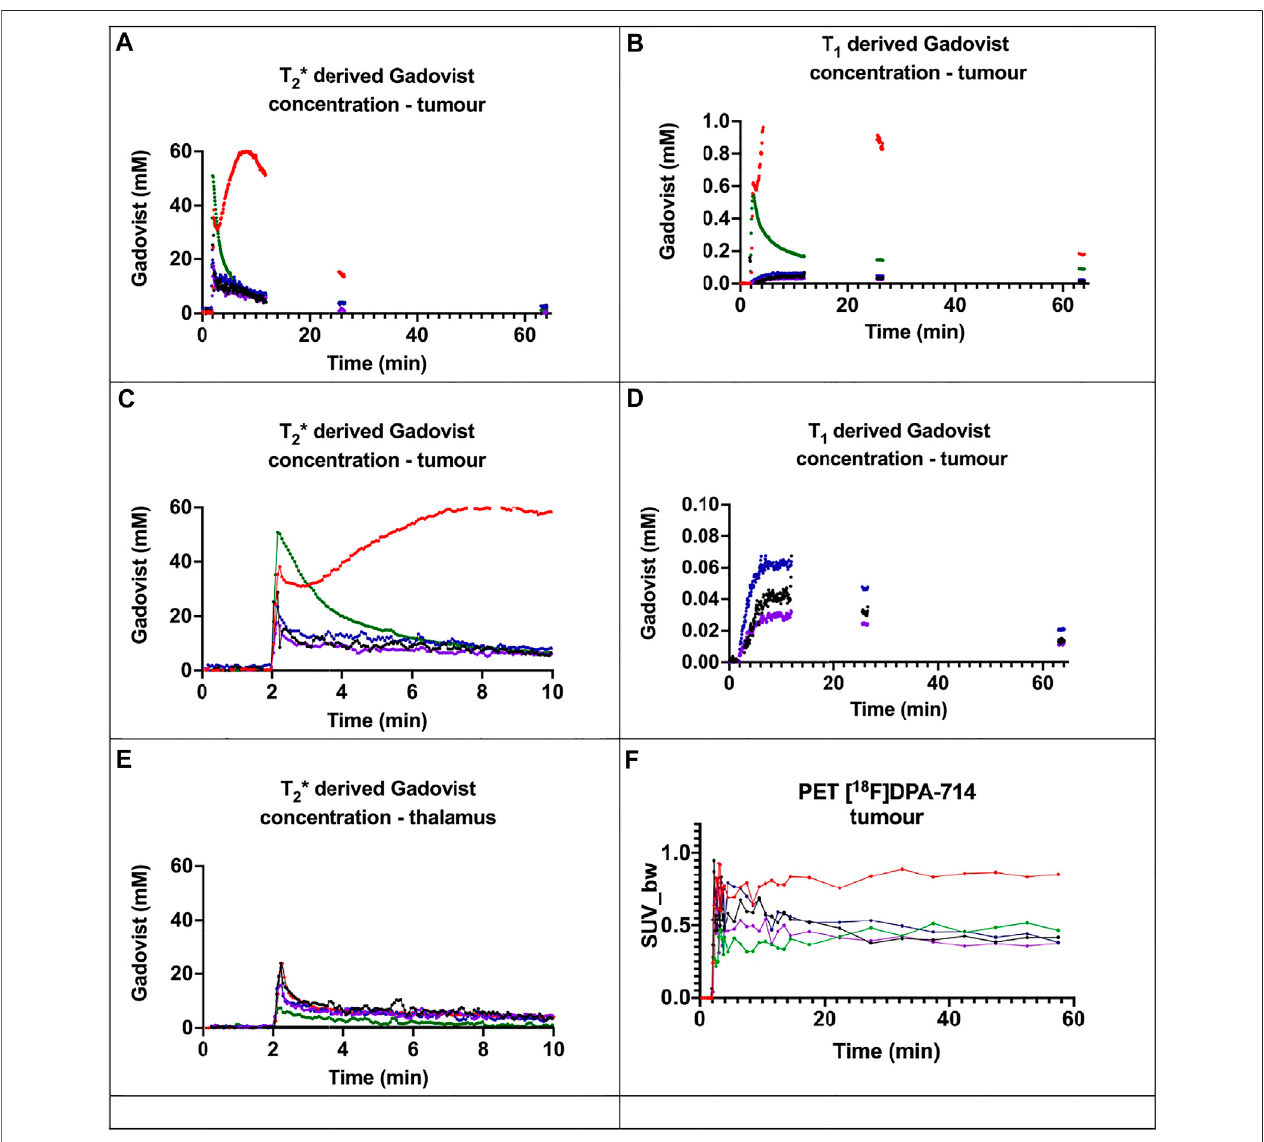
FIGURE 3 | Gadovist concentration derived from the changes in: (A) T 2 *; (B) T 1 ; (C) fi rst 10 min of T 2 * derived Gadovist concentration in the tumour (D) expanded scaleofT 1 derivedGadovistconcentrationofmice3,4,and5; (E) fi rst10 minofT 2 *derivedGadovistconcentrationinthethalamus (F) tumourtimeactivitycurvefor[ 18 F] DPA-714.Formouse1in (B) ,themaximumcalculatedvaluewas~5,000 nmol,above whichthecalculationfailed. Mouse1-red, mouse 2-green,mouse 3-blue,mouse 4 black and mouse